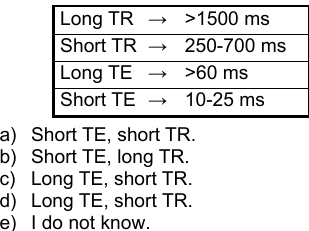
Figure A3. Instrument page 3 of